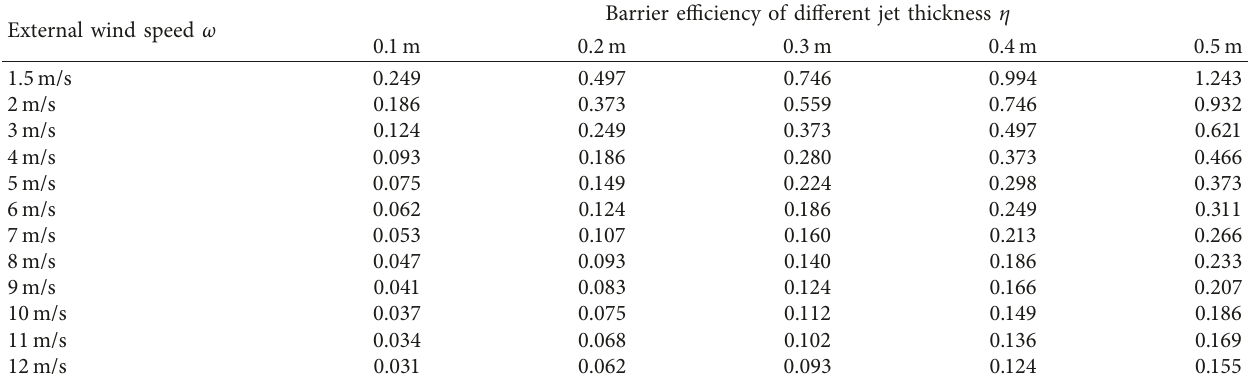
Table 3: The relationship between jet thickness and wind velocity outside the tunnel, barrier efficiency.